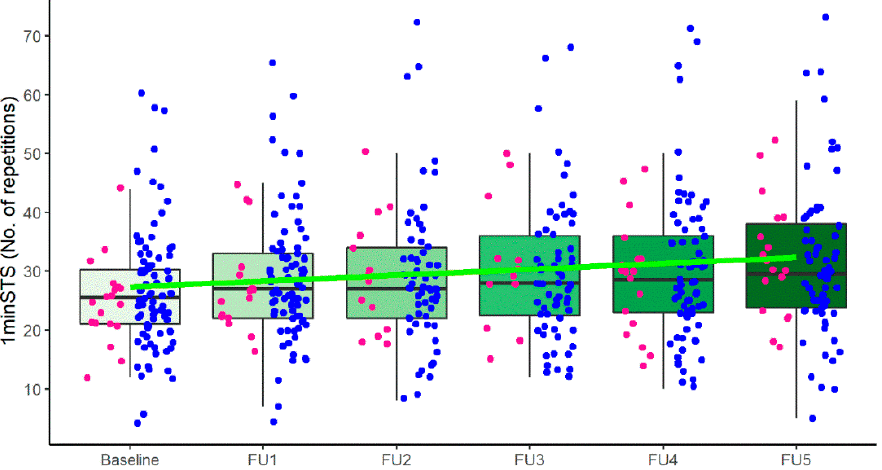
Figure 1. Number of repetitions in the one-minute sit-to-stand test (1minSTS) over 6 months. Time was defined as number of days between baseline and follow-up assessments; the green line represents the linear tendency, considering time a continuous variable; blue dots represent male patients and pink dots represent female patients; No.: number.